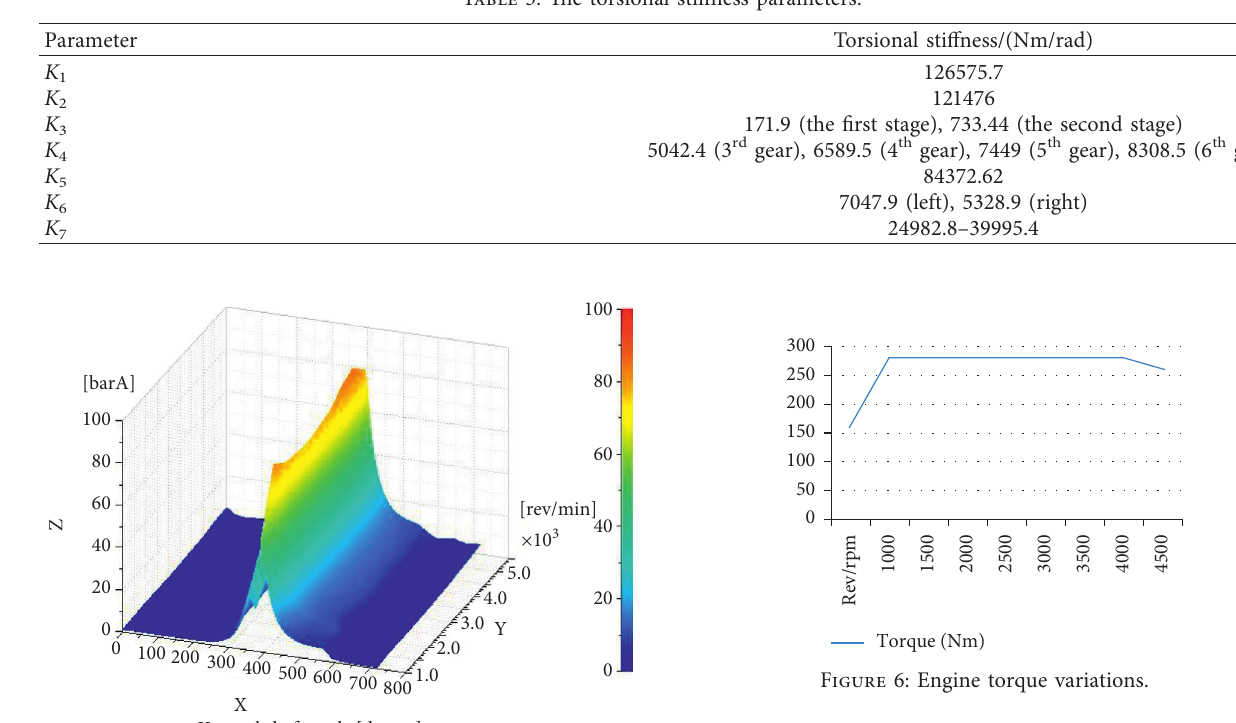
Table 3: The torsional stiffness parameters.